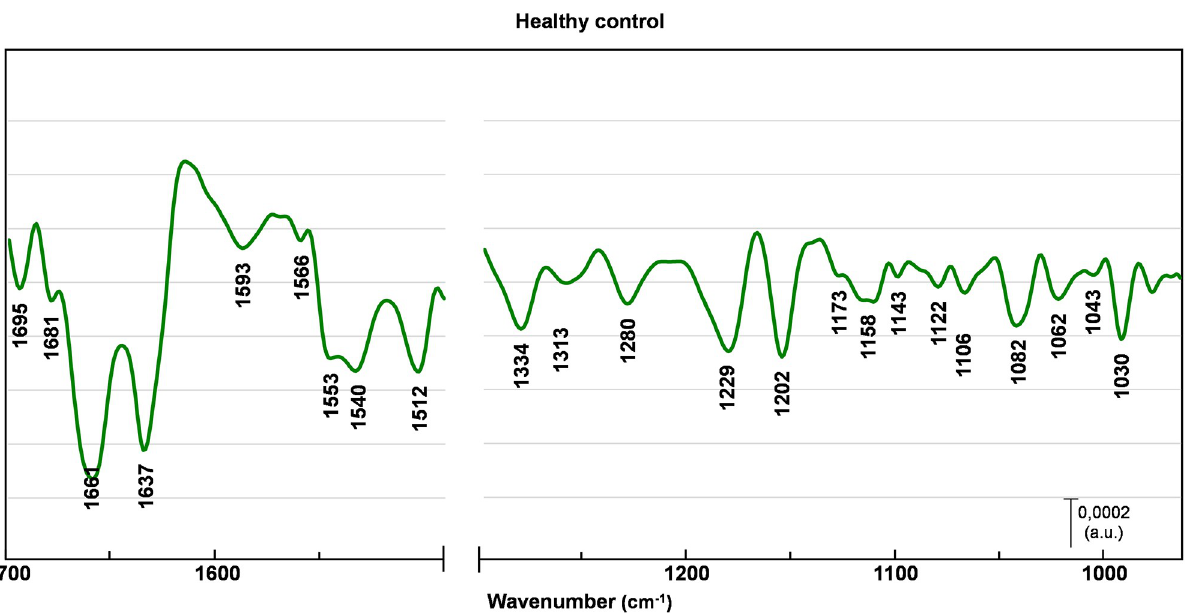
Fig 2. Healthy control averaged spectrum. EMSC-corrected 2nd derivative spectra of healthy control breast tissue with assigned minima.